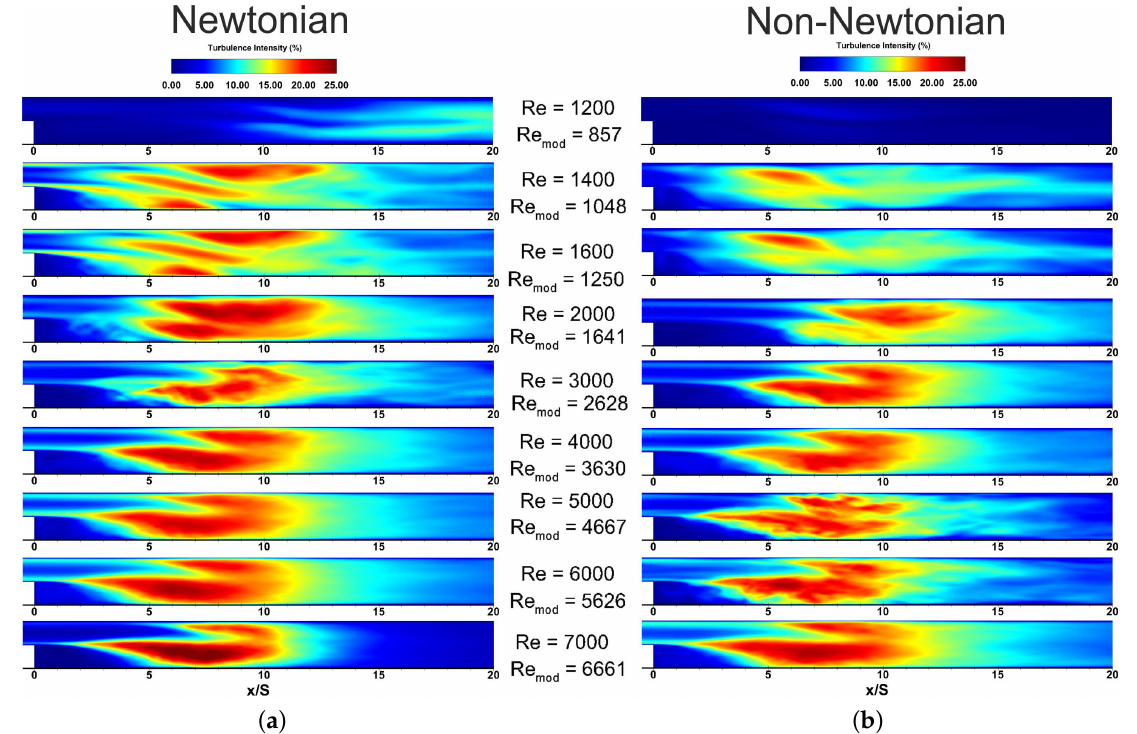
Figure 12. Turbulence intensity contour plots of each Reynolds number for Newtonian ( a ) and shear-thinning ( b ) blood